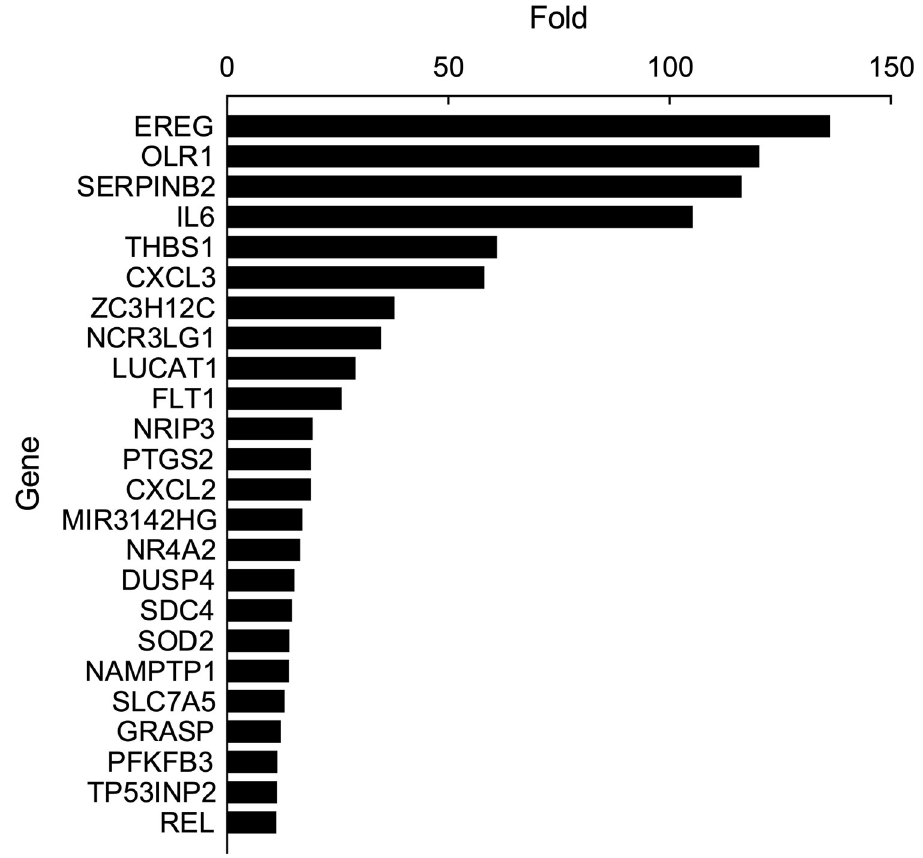
Fig 6. List of top 24 genes by fold up